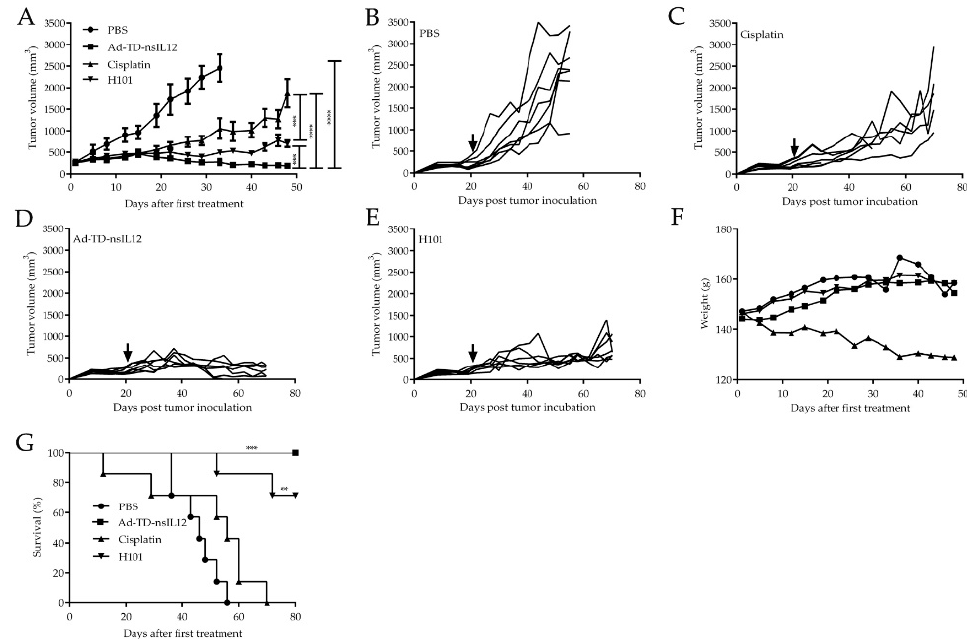
Figure 4. Ad-TD-nsIL12 can effectively control tumor growth in SBRC-EC01 subcutaneous xenograft tumor model. ( A – E ) SBRC-EC01 cells were used to establish a xenograft model in ZZU001 hamsters. 1 × 10 7 cells were seeded into the right flank of ZZU001. When the tumors reached 300 mm 3 , Ad-TD-nsIL12 (5 × 10 8 PFU), H101 (5 × 10 8 PFU) or PBS were each injected intratumorally on days 0, 2, 4. 6, 8